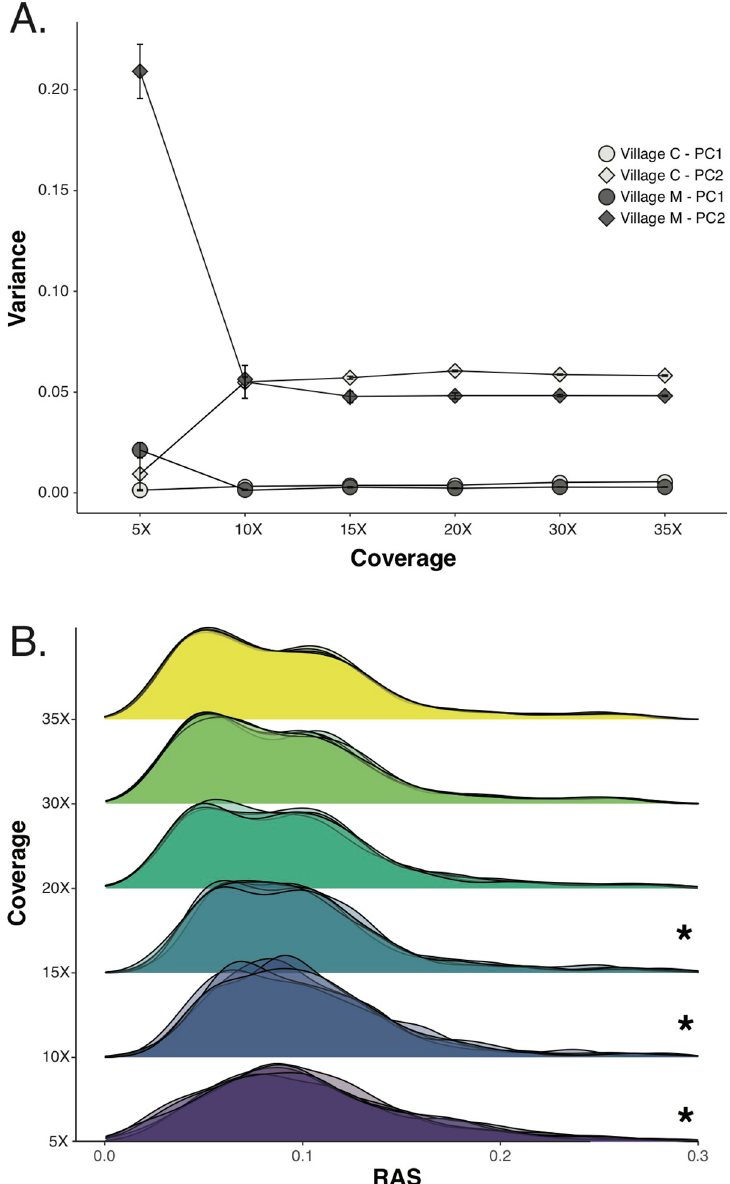
Fig 4. Effects of downsampling overall genomic coverage on estimates of the genetic variance and rare allele sharing across samples. A) Line graphs showing the differences in PC1 and PC2 variance for each village for all exonic variant downsampled datasets. For each coverage level, variances were estimated for each of five downsampled replicates; dots represent the mean variance across all replicates, with error bars indicating variance across replicates. B) Distributions of the proportion of rare alleles shared for all replicates for each downsampled coverage dataset. Coverage datasets that were significantly different from 35x are indicated by an asterisk. For each level of coverage, individual lines represent RAS distributions estimated from 5 replicates of resampling mapped